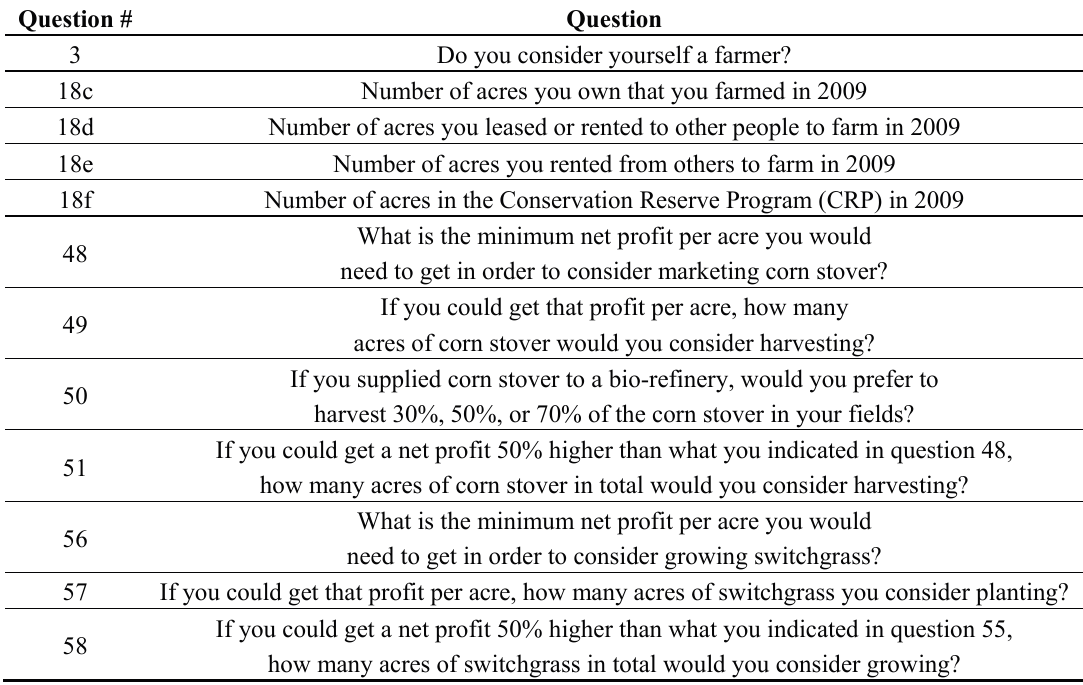
Table A1. Land use survey questions adopted for model